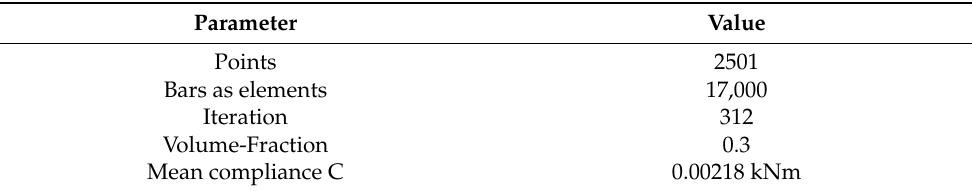
Figure 11. From left to right: tetrahedron-surface-mesh of the generated geometry, quad-mesh of the geometry, vertical section through the node and horizontal section through the node. The calculation was performed without an additional condition. Table 2. Parameter of the geometry finding